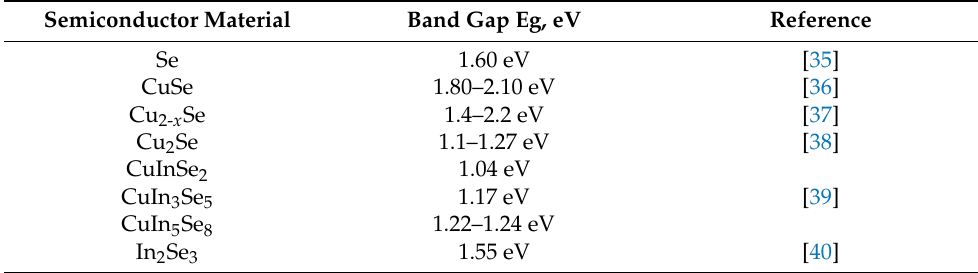
Table 2. The band gap values of selenium, copper selenide, copper indium selenide, and indium selenide found in the